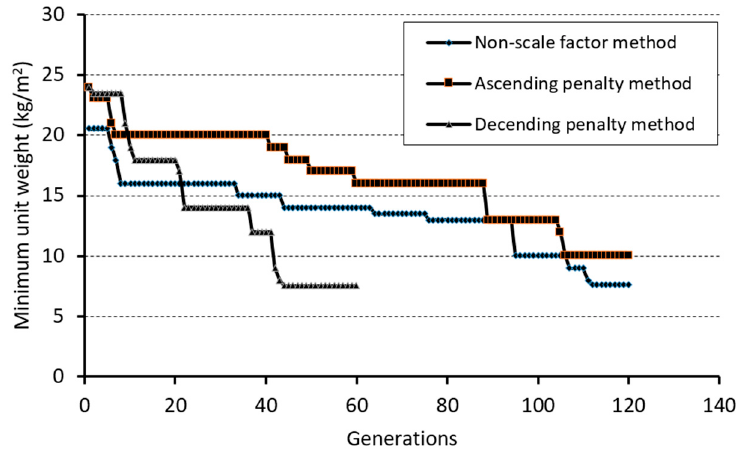
Figure 9. Convergence history of GA runs with three penalty strategies.